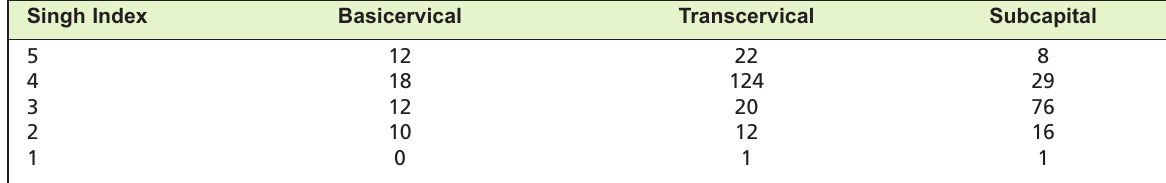
Distribution of the fractures according to Singh index Table IV: